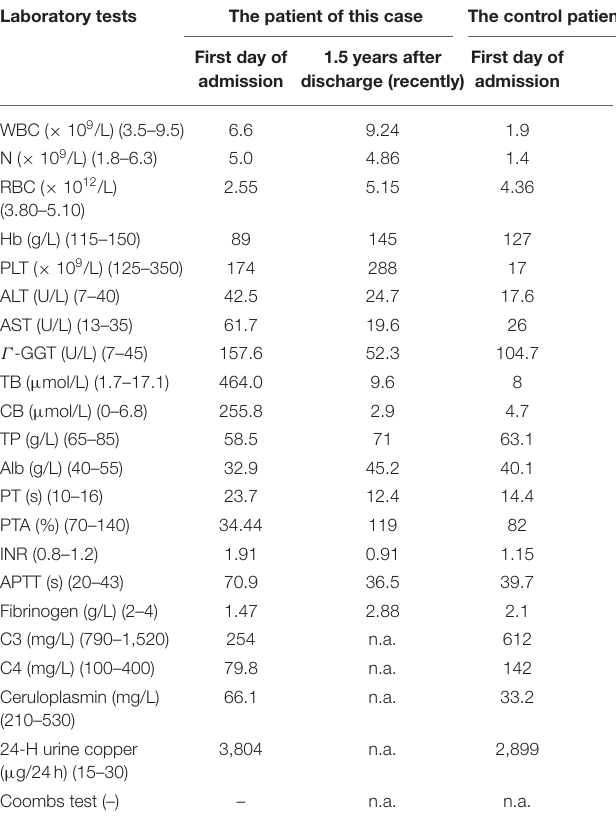
TABLE 1 | Laboratory results of the patient at the first day of admission and 1.5 years after discharge and a data comparison of another WD patient with a different